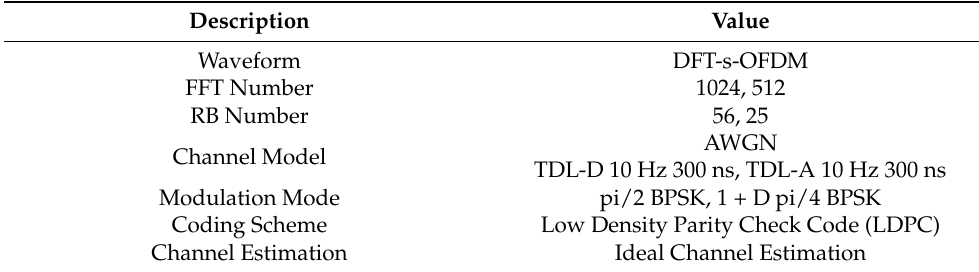
Table 6. Simulation